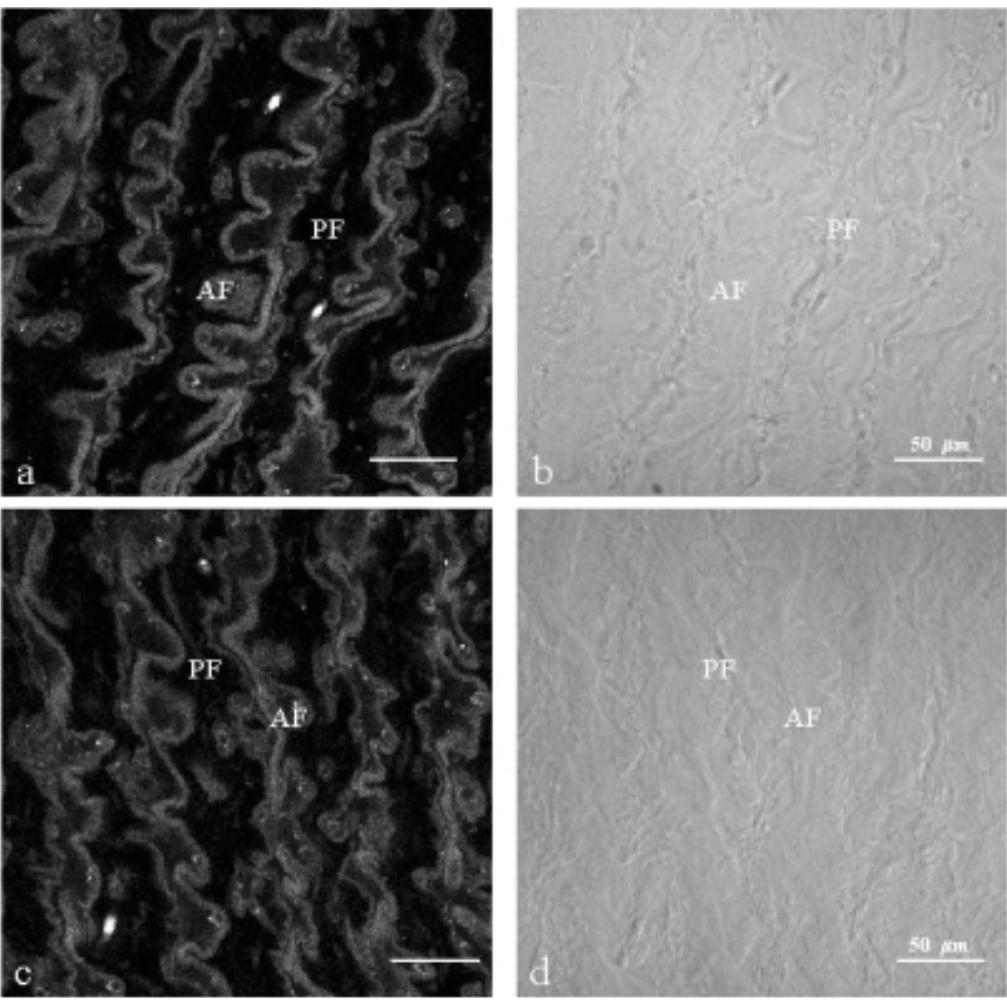
Fig. 2a-b – Thin section (10 µ m) of normal contralateral electric tissue a: immunolabelled with policlonal antibody anti-ChAT. Immunoreactivity is essentially cytoplasmatic; b: differential interferencial contrast. AF; anterior face, PF; posterior face. Fig. 2c-d - Thin section (10 µ m) of denervated electric tissue ( 60 days ), c: immunolabelled with policlonal antibody anti-ChAT, The same pattern of labelling in cytoplasm is observed when compared to normal contralateral tissue; d: differential interferencial contrast. AF; anterior face, PF; posterior